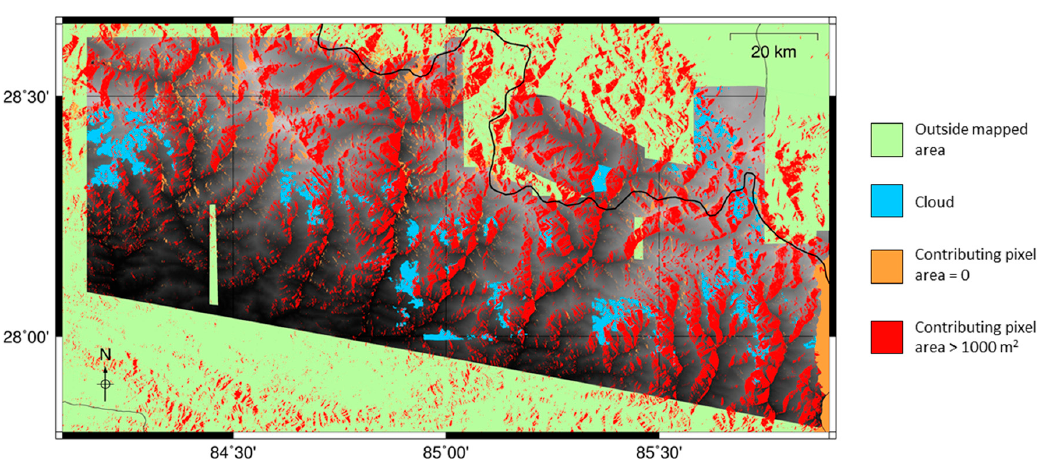
Figure 7. Regions that were masked before analysis was carried out, either due to being unmapped by Roback et al. [2] (green, blue) or because of poor SAR image quality, identified using the contributing pixel area (orange, red). Underlying surface shows topography.